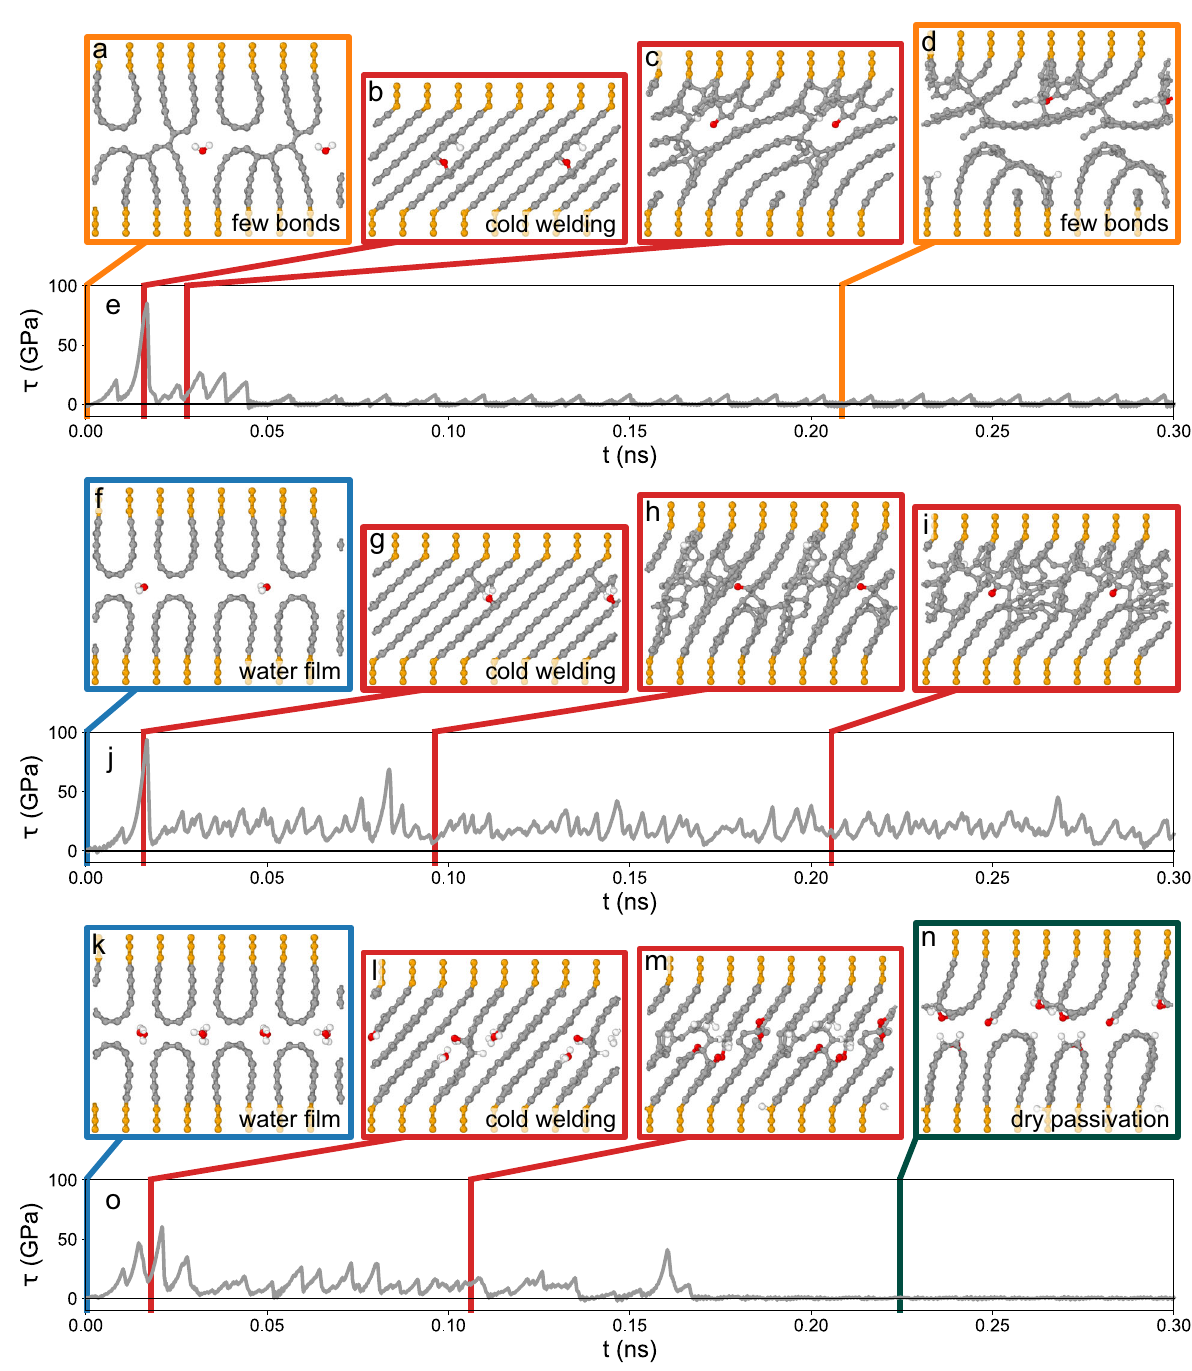
Fig. 9 | Structural evolution of graphite slabs during sliding in atomistic simulations. a – d Two loop terminated graphite blocks in contact with one water molecule at a normal pressure of 1GPa and the corresponding evolution of the shear stress τ ( t ) ( e ). Upon sliding, aromatic structures form at the interface. a – d Snapshots of the trajectory, duplicated in horizontal direction. f – i Snapshots